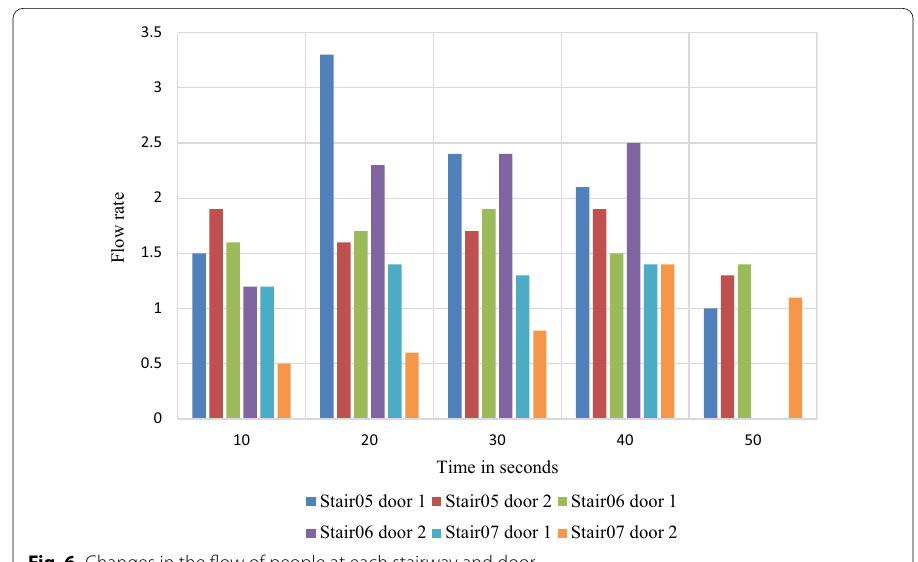
Fig. 6 Changes in the flow of people at each stairway and